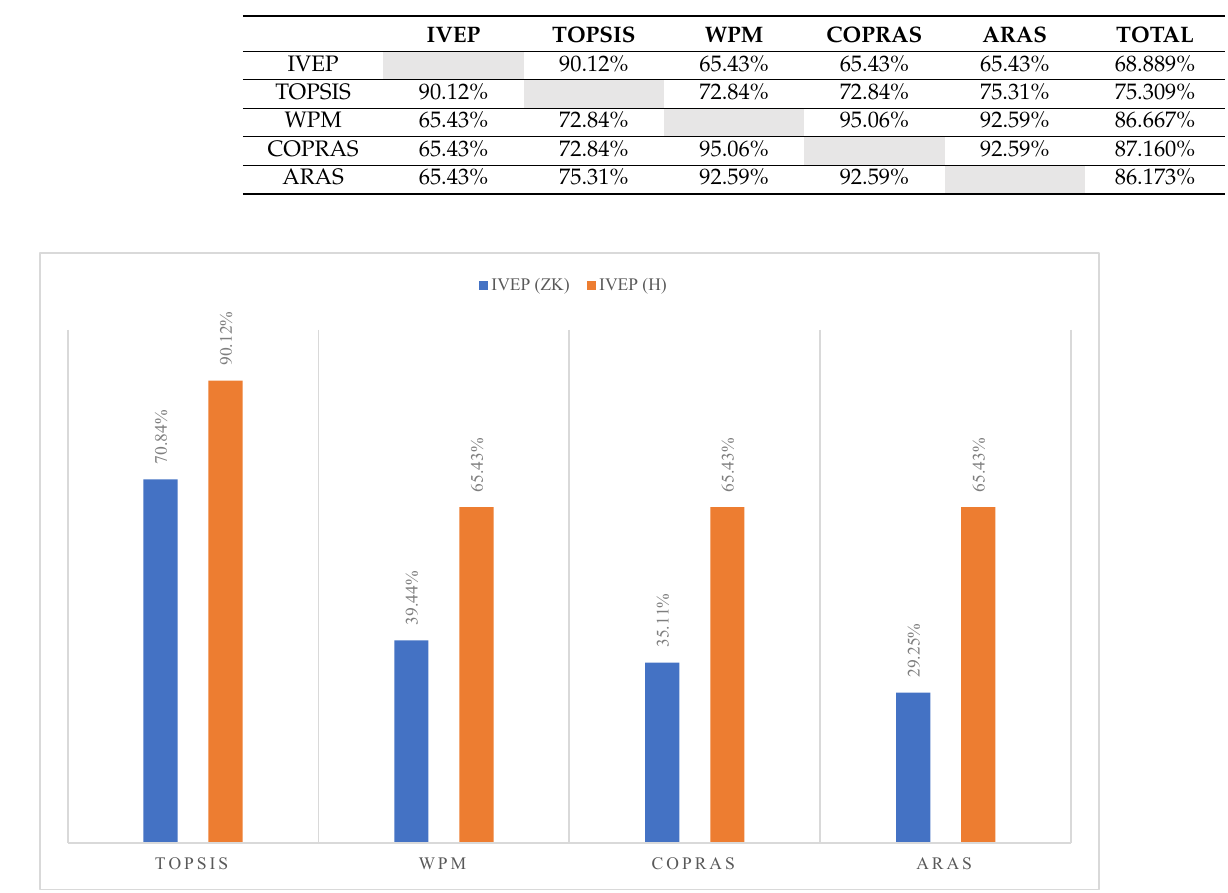
Figure 7. The comparison of the similarities of the MCDM algorithms’ outputs generated by the Zakeri–Konstantas performance correlation coefficient (ZK) and the Hamming distance (H).